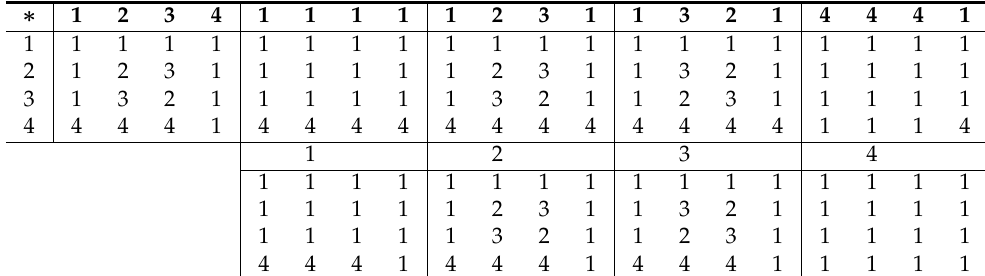
Table 4. Extended table of Example